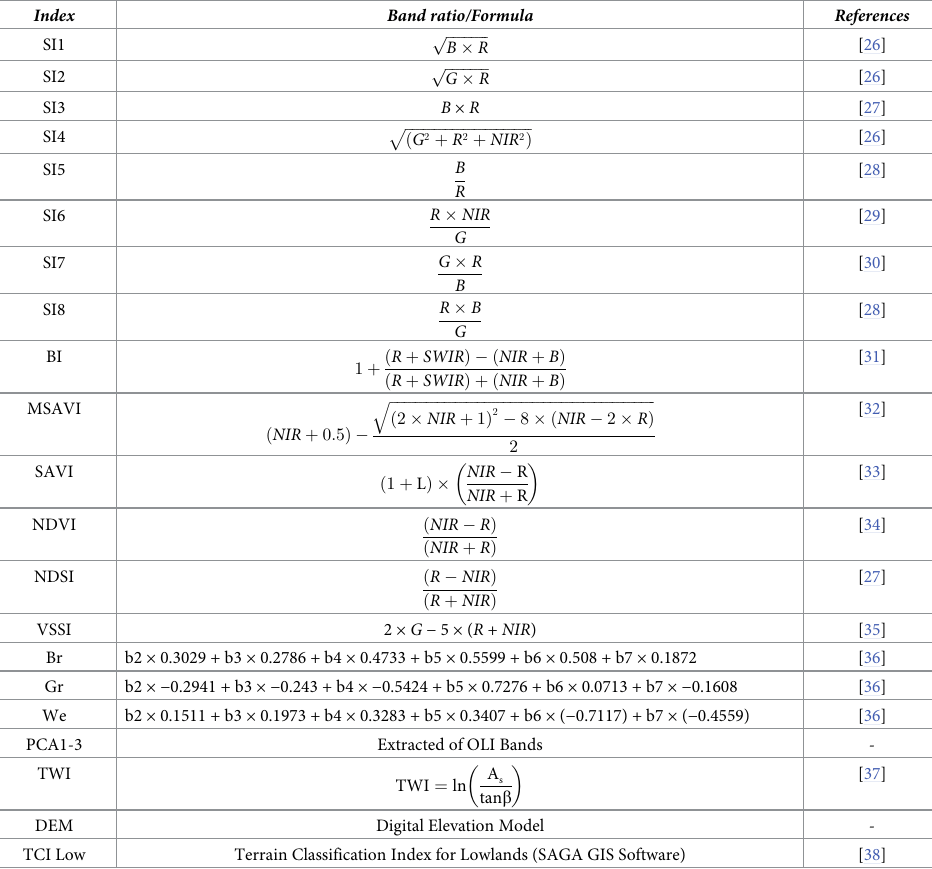
Table 1. The indices used in this study.